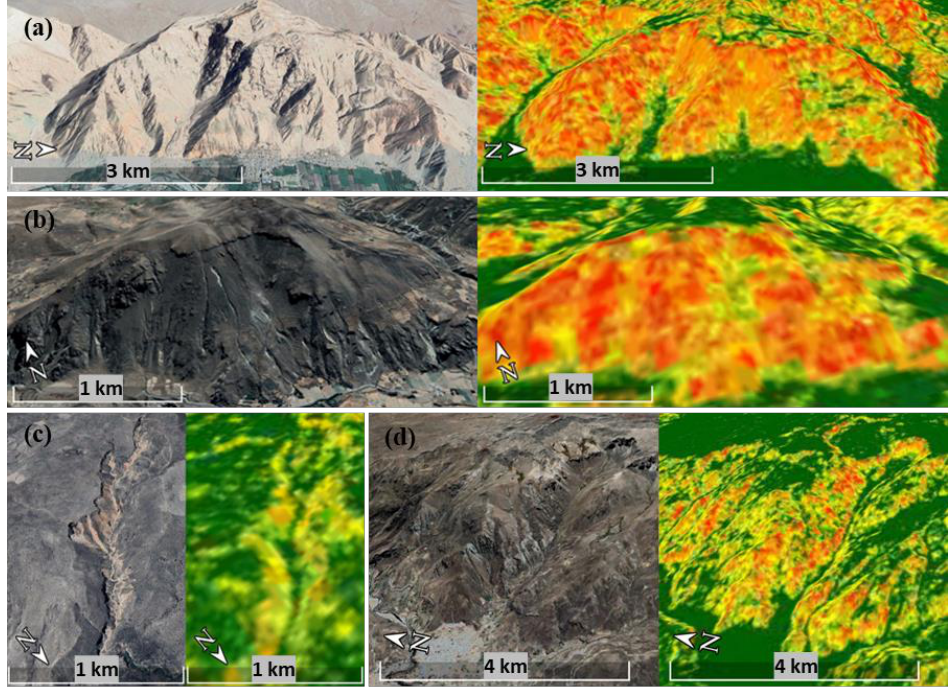
Figure 15. A zoomed view of Google Earth imagery showing the landslide-prone areas in the vicin- ity of major communities (( a ) Aplao, ( b ) Cabanaconde, ( c ) Chuquibamba, and ( d ) Chivay) and their corresponding susceptibility mapped by the ensemble ML model. The dark green and dark red in- dicate the lowest and highest landslide susceptibility, respectively.